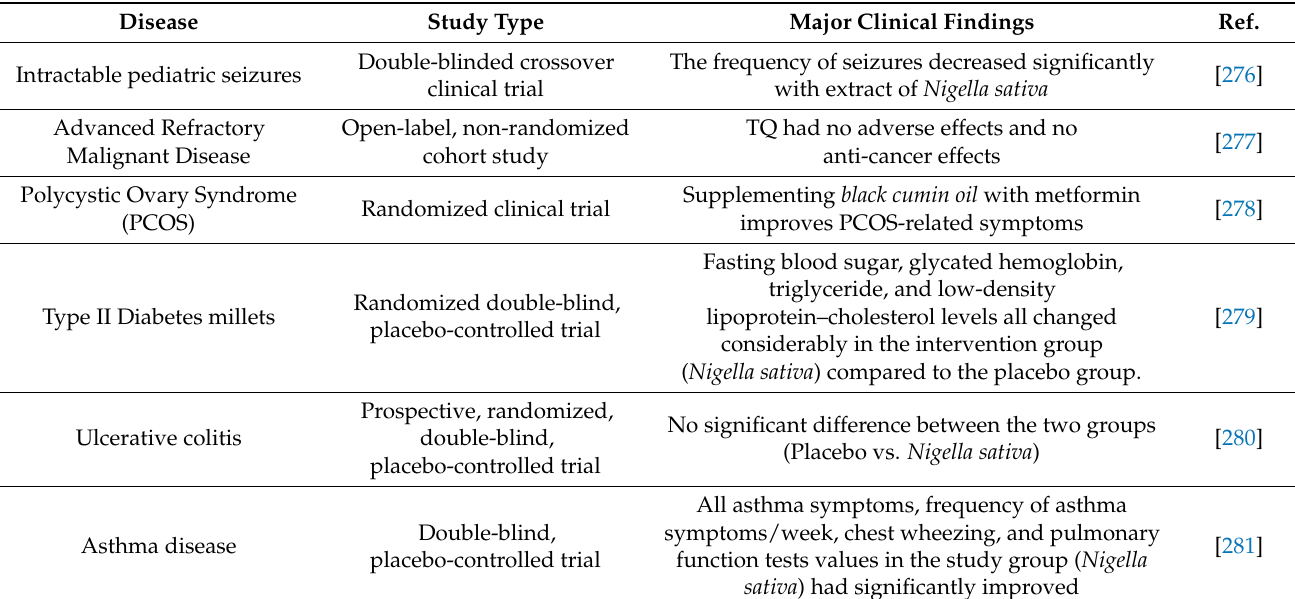
Table 1. Summary of TQ application in clinical trials for various